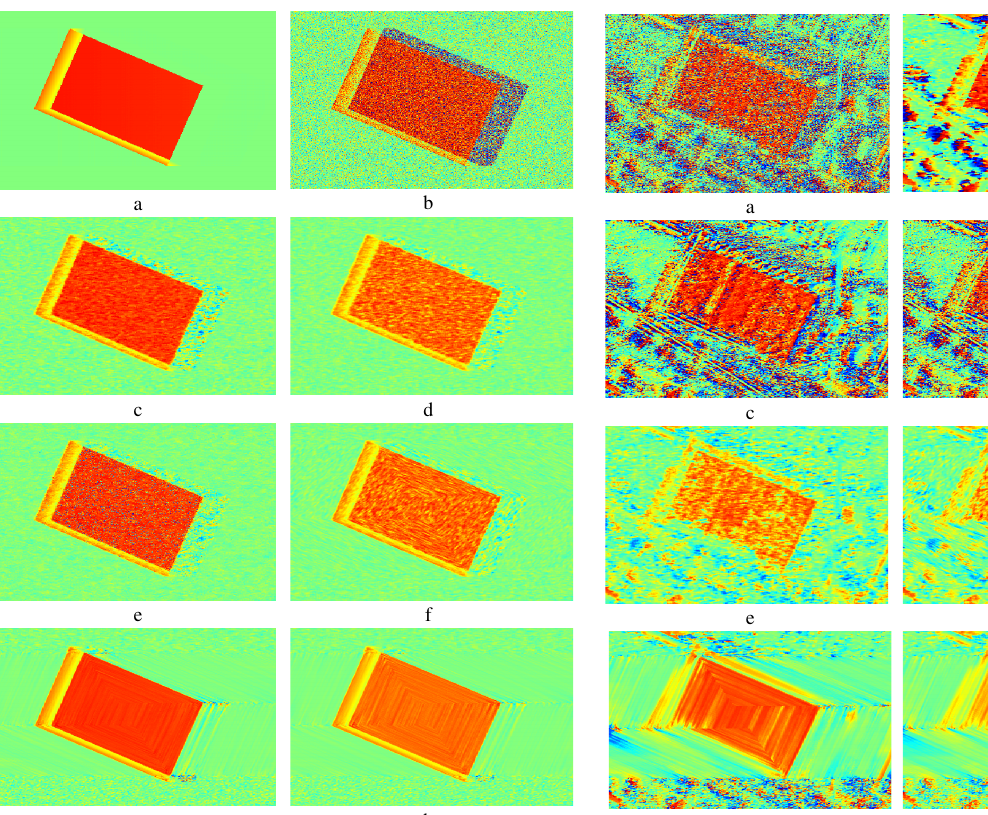
Figure 5. Filtering of real interferometric phases: a) original measured interferometric phases, b) Multilook-filter, c) Goldstein-filter, d) Baran-filter, e) mean-coherence-filter, using GIS information for f) fixed-window-filter (mean- coherence), g) adaptive-window-filter (median), and h) adaptive-window-filte